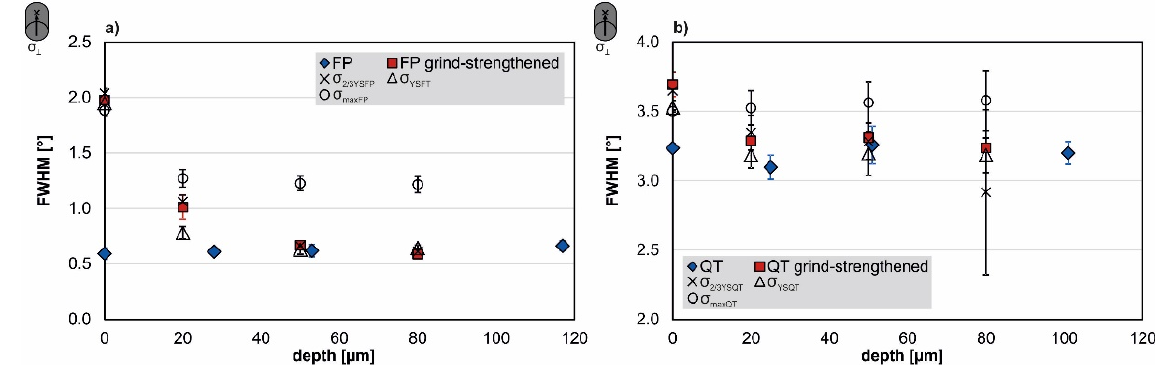
Figure 8. Full width at half maximum transverse to grinding direction in ( a ) FP- and ( b ) QT-condition.